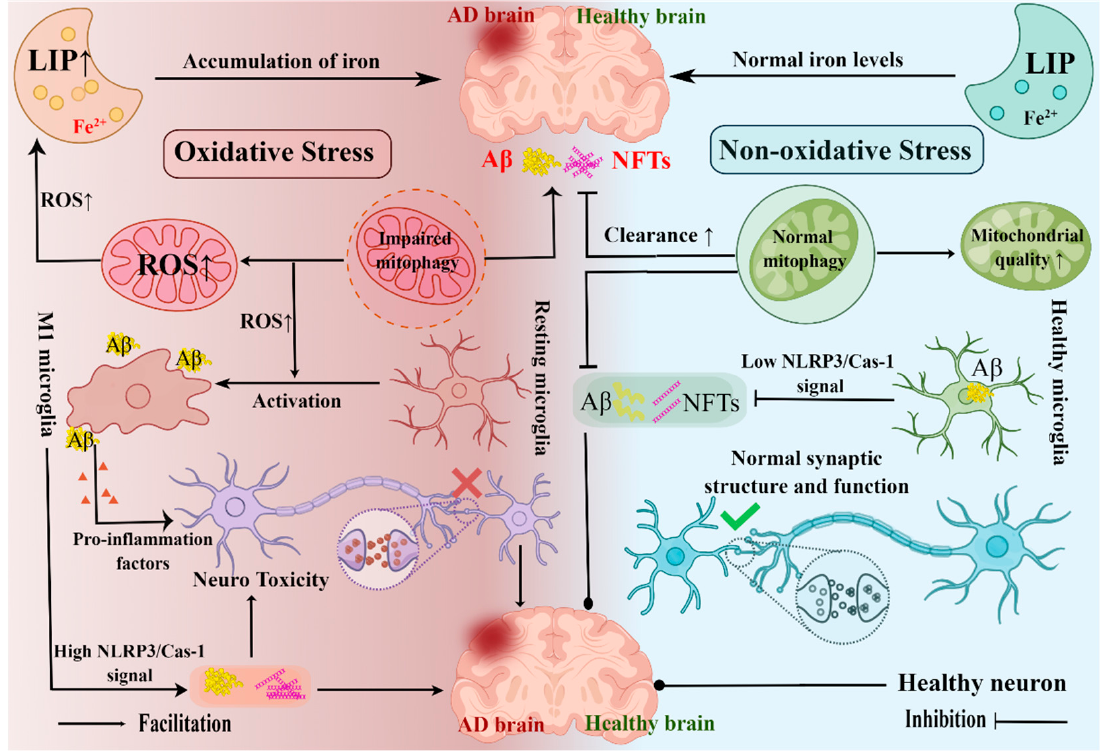
Figure 2. Association between hippocampal pathology and AD disease. AD is characterized by the accumulation of A β and hyperphosphorylation of tau protein which lead to neuronal degeneration and changes in synaptic structure and function, leading to neurotoxicity. The damage of mitophagy can lead to the reduction in mitochondrial quality and abnormal mitochondrial function. On the one hand, it promotes the progression of AD pathology. On the other hand, the abnormal mitochondrial function also leads to increased ROS release, which may further lead to hippocampal iron accumu- lation and neuroinflammation, and then lead to A β accumulation and hyperphosphorylation, which may eventually lead to neurotoxicity and AD. AD: Alzheimer’s disease, LIP: Labile iron pool, A β : Amyloid beta, NFTs: Neurofibrillary tangles, √ : Protective effect, ×: Damaging effect (Drawn by